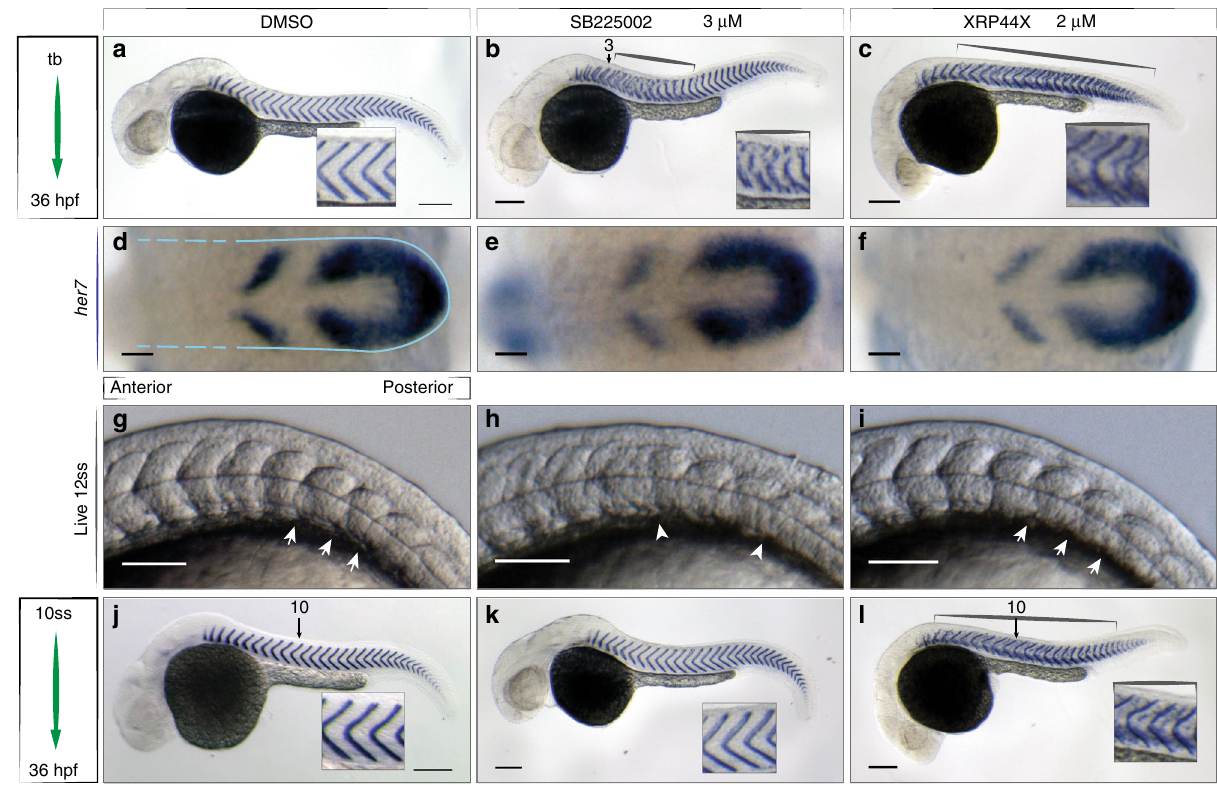
Fig. 5 Small molecules perturb segmentation at distinct steps. Wild type embryos after in situ hybridization for xirp2a mRNA at 36 hpf to mark myotome boundaries a – c , j – l , her7 mRNA at 10 ss to show segmentation clock expression d – f , and live at 12 ss to show somite boundaries, N = 3 g – i , treatments as indicated. a 0.5% DMSO-treated control embryos. b 3 µ M SB225002 treatment from tailbud (tb), myotome boundary defects of the mid-trunk, segments 3 – 15 (brackets, inset). c 2 µ M XRP44X, segment defects along axis (brackets), ectopic staining of xirp2a within myotomes (inset). d - f Cyclic her7 mRNA normal in all treatments. Blue outline indicates PSM, broken lines indicate area of formed somites, ( n = 45, 3 of 3 experiments). g 0.5% DMSO and i 2 µ M XRP44X showed normal somite formation with intact formed somite boundaries (arrows). h 3 µ M SB225002, no clear somite boundaries posterior to somite 5 (arrowheads). Last somite boundary not detectable ( n = 30, 2 of 3 experiments). j – l Treatments starting from 10 ss as indicated. j Normal segmentation in control. k 3 µ M SB225002 no effect on myotome boundaries (inset) ( n = 50, 5 of 7 experiments). l 2 µ M XRP44X, myotome boundary defects along axis (brackets, insets), affecting segments formed prior to treatment ( n = 40, 3 of 4 experiments). Scale bar for a – c , j – l = 200 µ m, d – i = 50 µ